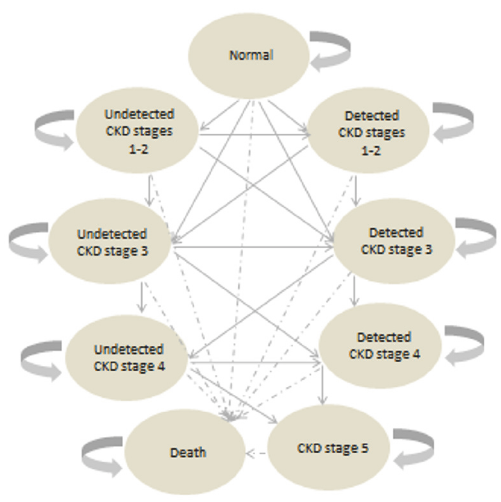
Figure 1: Markov state transition model for the progression of